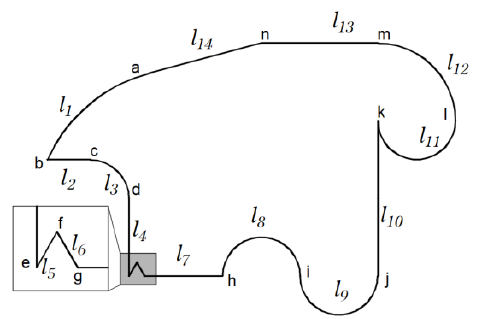
Figure 4. Pending inspection image in this paper.